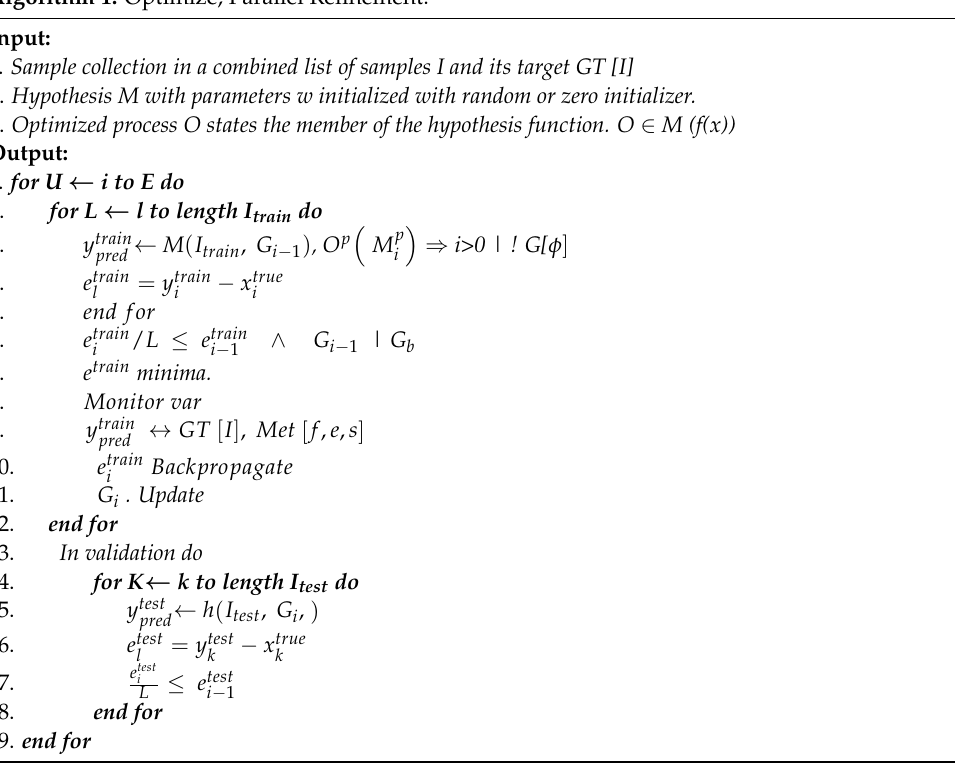
Algorithm 1. Optimize, Parallel Refinement.